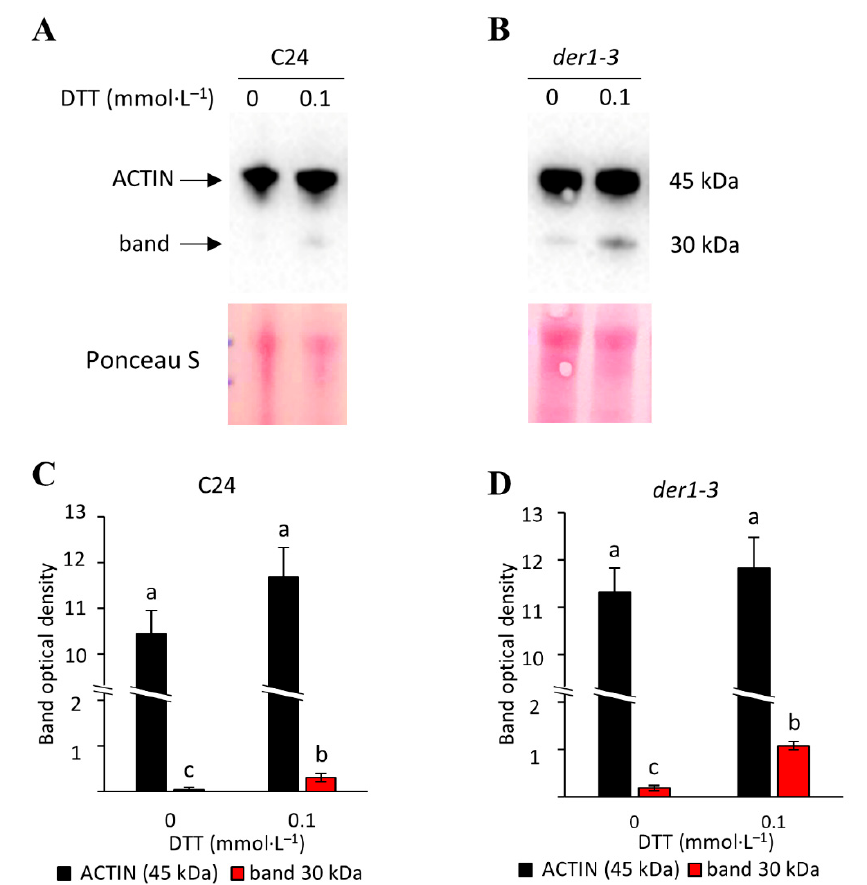
Figure 8. Examination of ACTIN sensitivity to dithiothreitol (DTT) in the C24 wild-type and der1–3 mutant. ( A – B ) Immunoblots of ACTIN prepared by using anti-ACTIN 2, 8, 11 primary antibody in the C24 wild-type ( A ) and der1–3 mutant ( B ). ( C , D ) Quantification of band densities in ( A , B ), respectively. Different lowercase letters above the bars ( C , D ) represent statistical significance between treatments according to t -Test at p value < 0.05. Uncropped, full original images of immunoblots are provided in Figure S11.